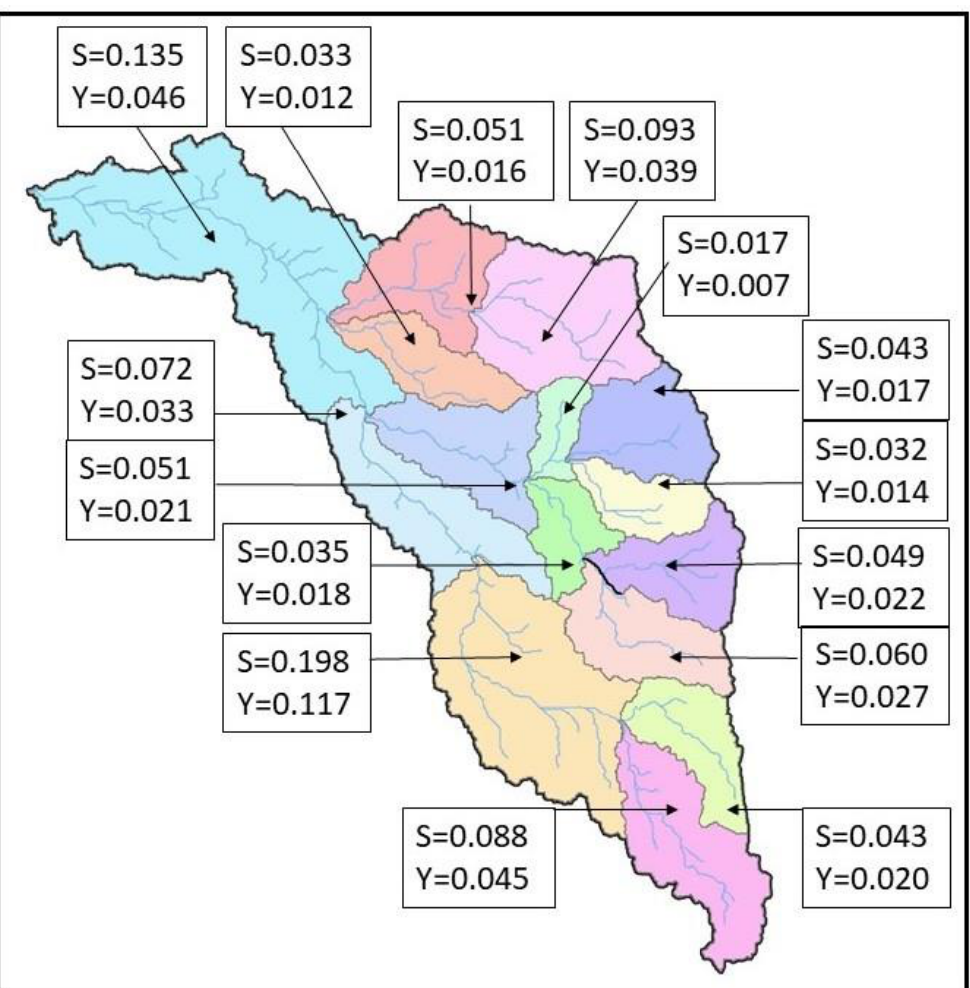
Figure 8. Feasible storage capacity (S) and withdrawals (Y) in each large sub-basin of Malwatu Oya for the entire basin to stay on the Mid scenario if the cumulative storage capacity were increased to 1.0 MAR unit. S and Y values given in terms of MAR units of the entire basin.